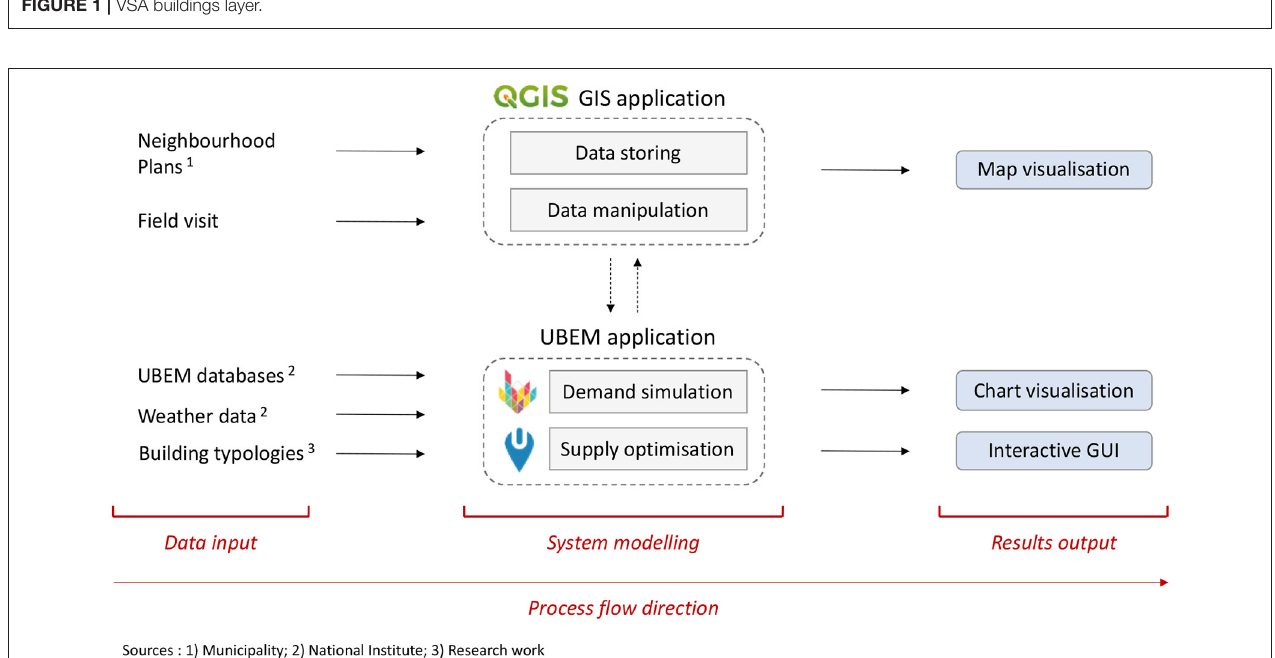
FIGURE 2 | The entire framework (incl. QGIS, CEA for demand simulation & Urbio for supply optimisation). Source: (1) Municipality; (2) National Institute; (3) Research Work.